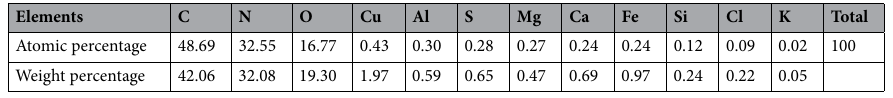
Table 1. The chemical contents of the elytral surface of the beetle D. tityus.